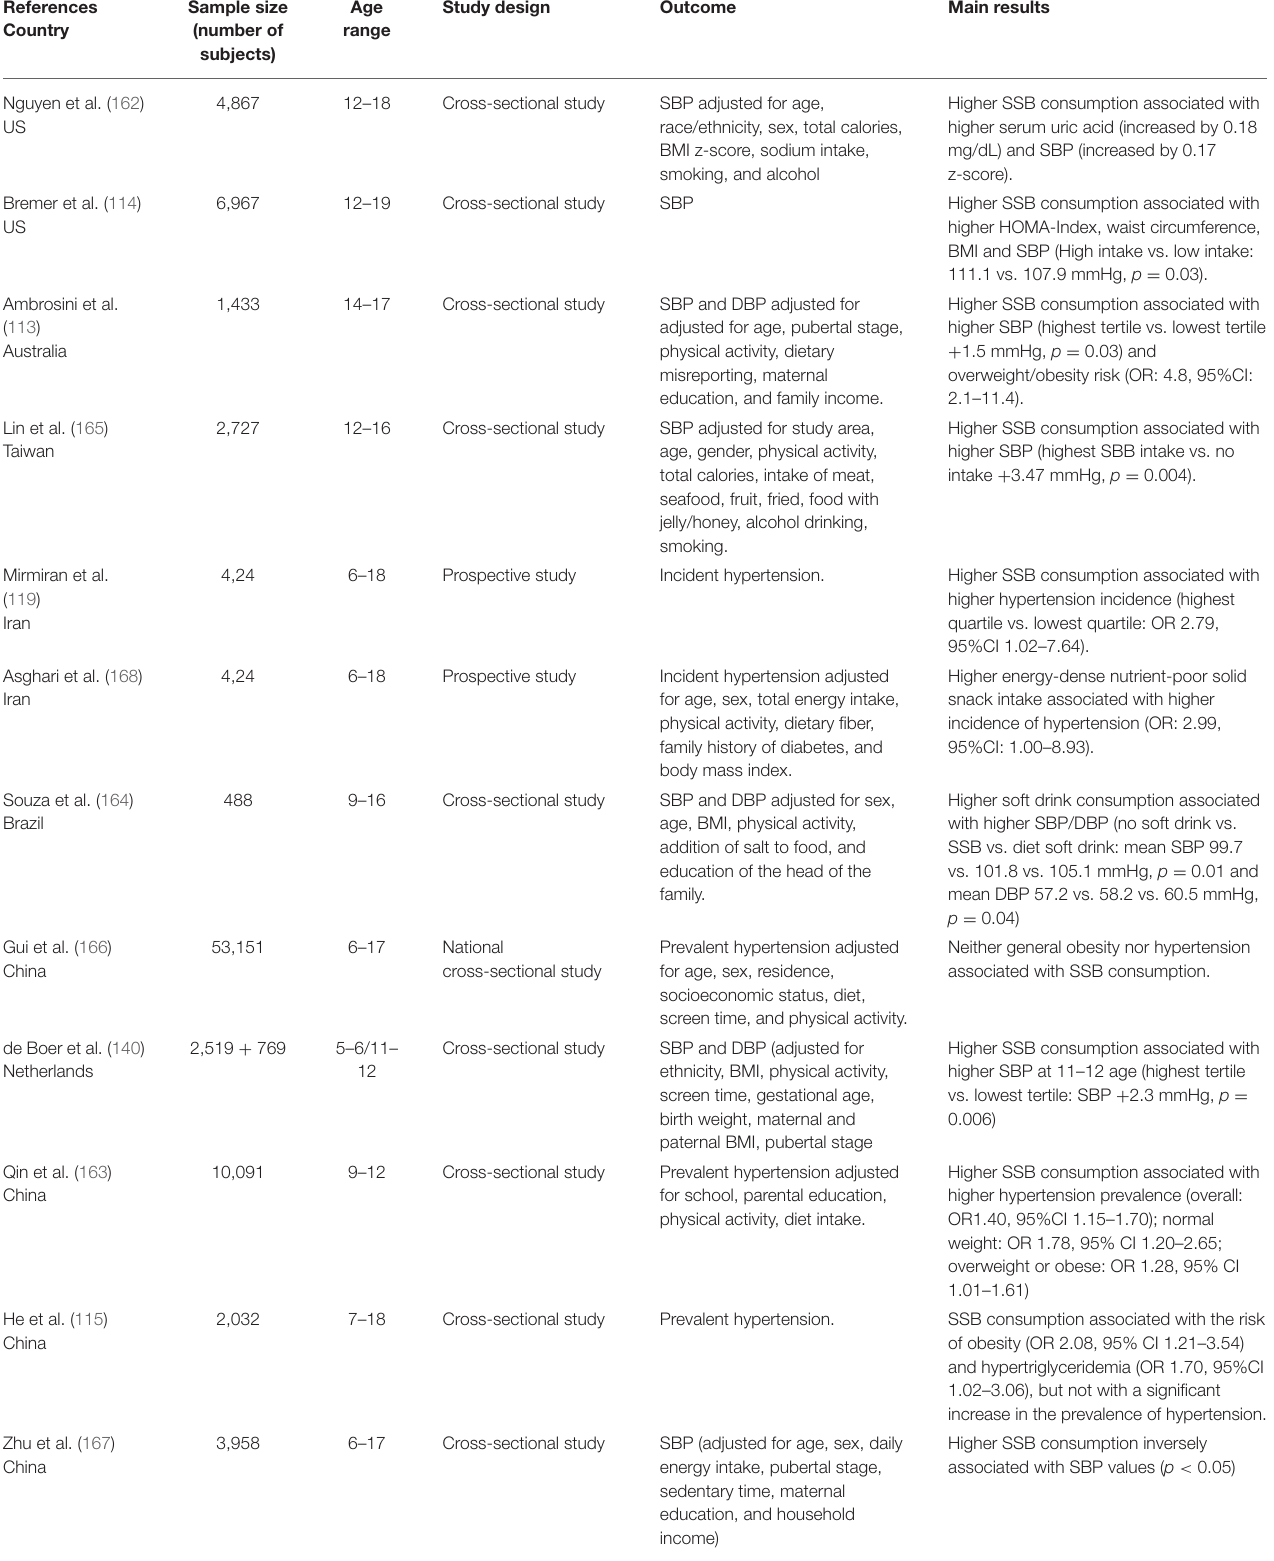
TABLE 3 | Main available studies assessing the relationship between SSB intake and BP in pediatric